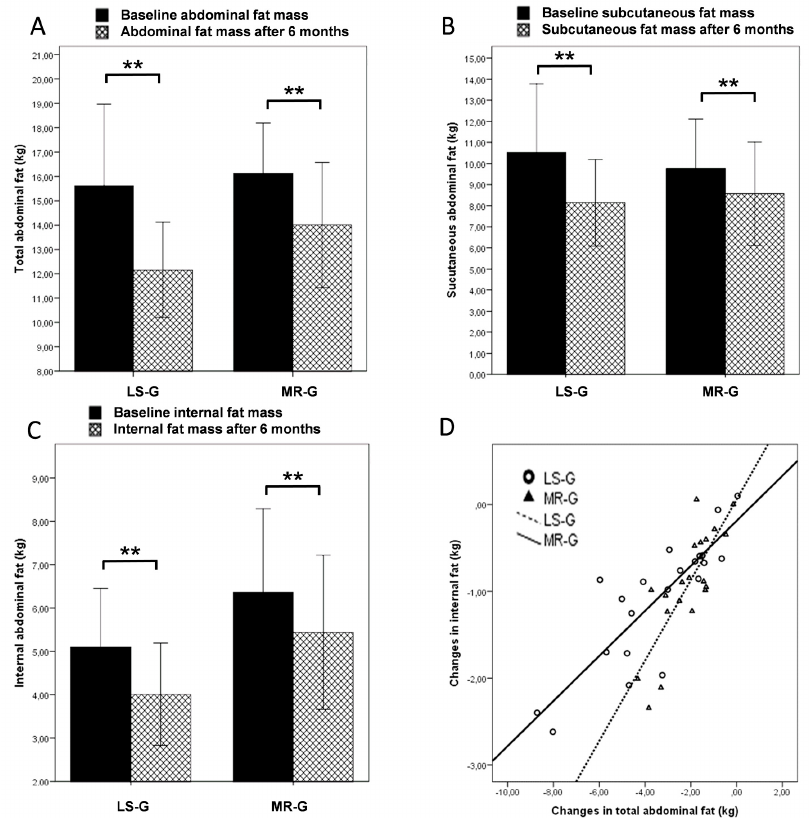
Figure 2. MRI findings: Changes in total abdominal fat mass ( A ); subcutaneous abdominal fat ( B ); internal abdominal fat ( C ) and the correlation between changes in total abdominal fat and internal abdominal fat in dependence of the intervention group (lifestyle changes LS ‐ G or meal replacement regimen MR ‐ G); black bars, baseline values; grey hatched bars, post ‐ interventional values after six months. (Error bars: ±1 standard deviation; *, p < 0.05; **, p < 0.01). Table 1. Weight and BMI during the course of the study. Mean ± standard deviation (SD). LS ‐ G, lifestyle intervention group; MR ‐ G, meal replacement group. §, p < 0.05 compared to baseline; ◊ , p < 0.01 compared to baseline (paired T ‐ Test). Differences between the intervention groups (ANOVA) were not significant at any point of the investigation. Baseline Mean (SD)